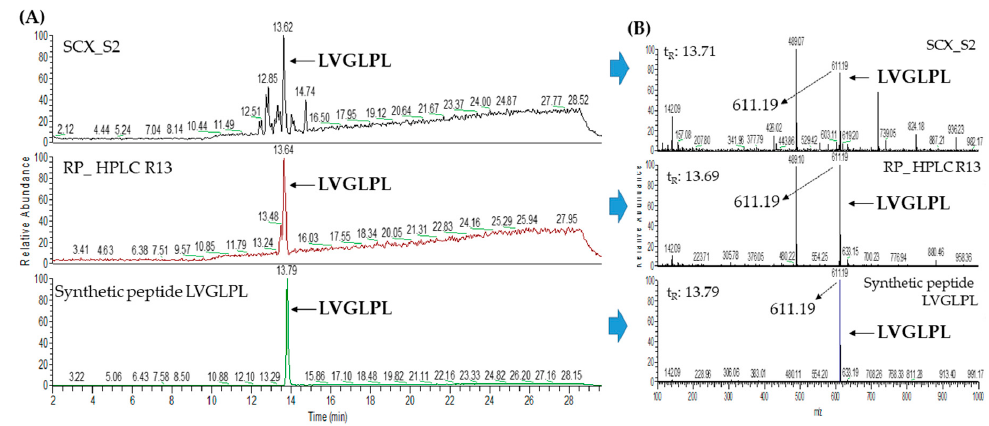
Figure A6. ( A ) LC–MS chromatograms of SCX S2, RP R13, and the synthetic peptide LVGLPL, ( B ) MS spectra of LVGLPL originated from fraction SCX S2 ( m / z 611.19, tR 13.71 min), fraction RP R13 ( m / z 611.19, tR 13.69) and synthetic LVGLPL ( m / z 611.19, tR 13.79).